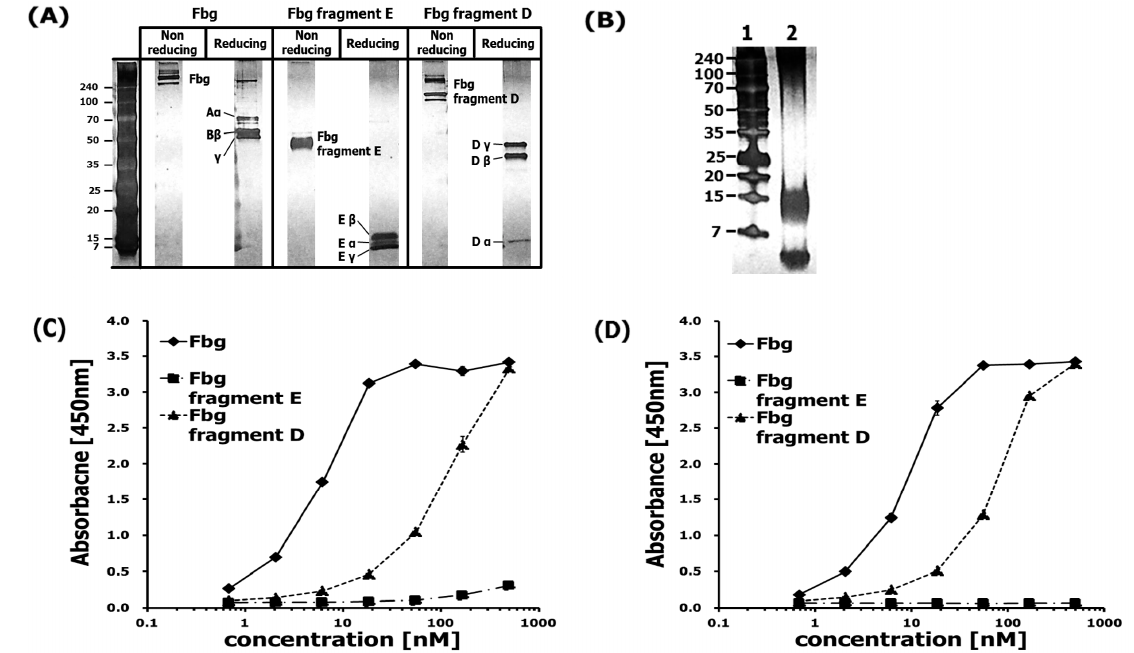
Figure 2. A β 42 binds to Fbg and its fragments. ( A ) Tris-tricine gel electrophoresis result for Fbg and its fragments D and E. ( B ) Tris-tricine gel electrophoresis result for: (1) protein marker, and (2) A β 42. ( C ) Binding of Fbg and its fragments was detected by the pAb. ( D ) Binding of Fbg and its fragments was detected by the mAb.